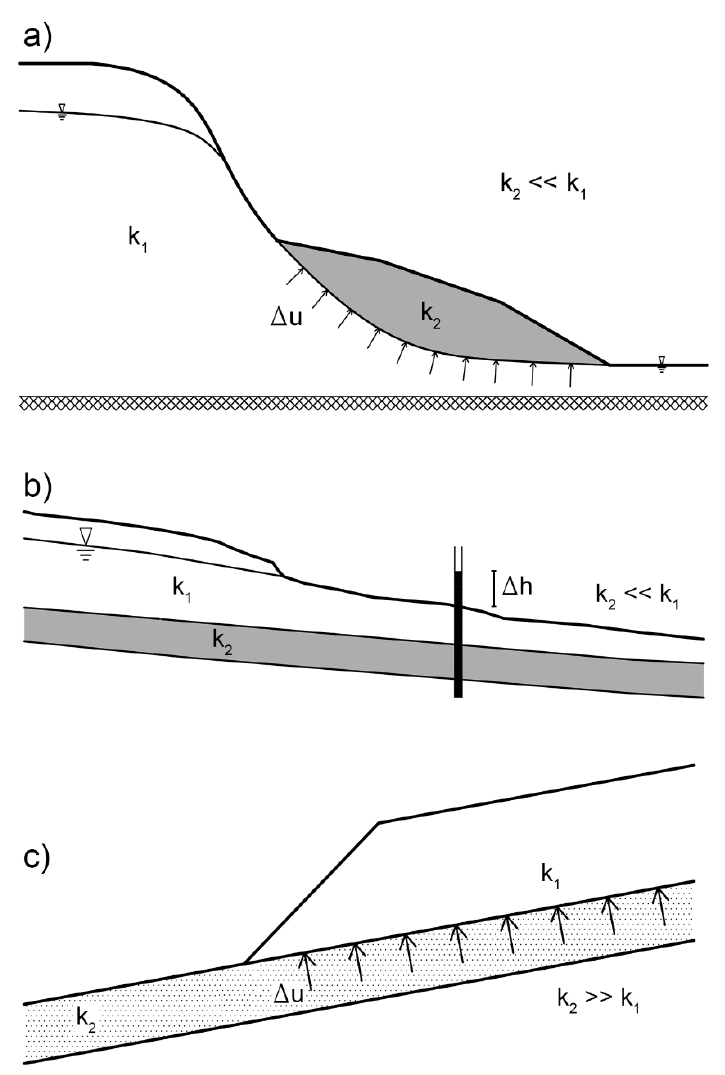
Figure 1. Some typical situations in which an excess of pore water pressure could trigger a landslide: ( a ) A slope with a low permeable cover soil; ( b ) A slope with a low permeable soil layer; ( c ) A slope with a high permeable soil layer. Δu: excess pore water pressure ; k 1 , k 2 : coefficient of permeability; Δh: increase in hydraulic head.